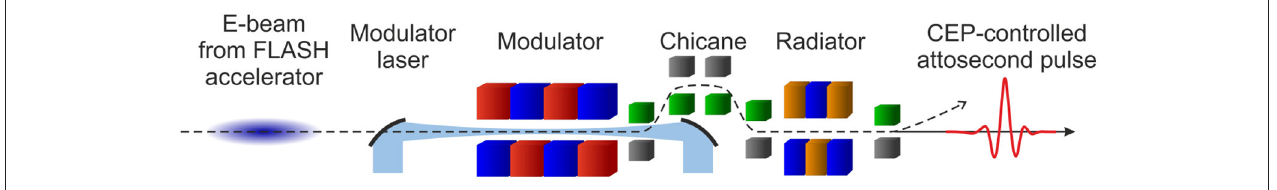
FIGURE 1 | Scheme of the investigated setup.